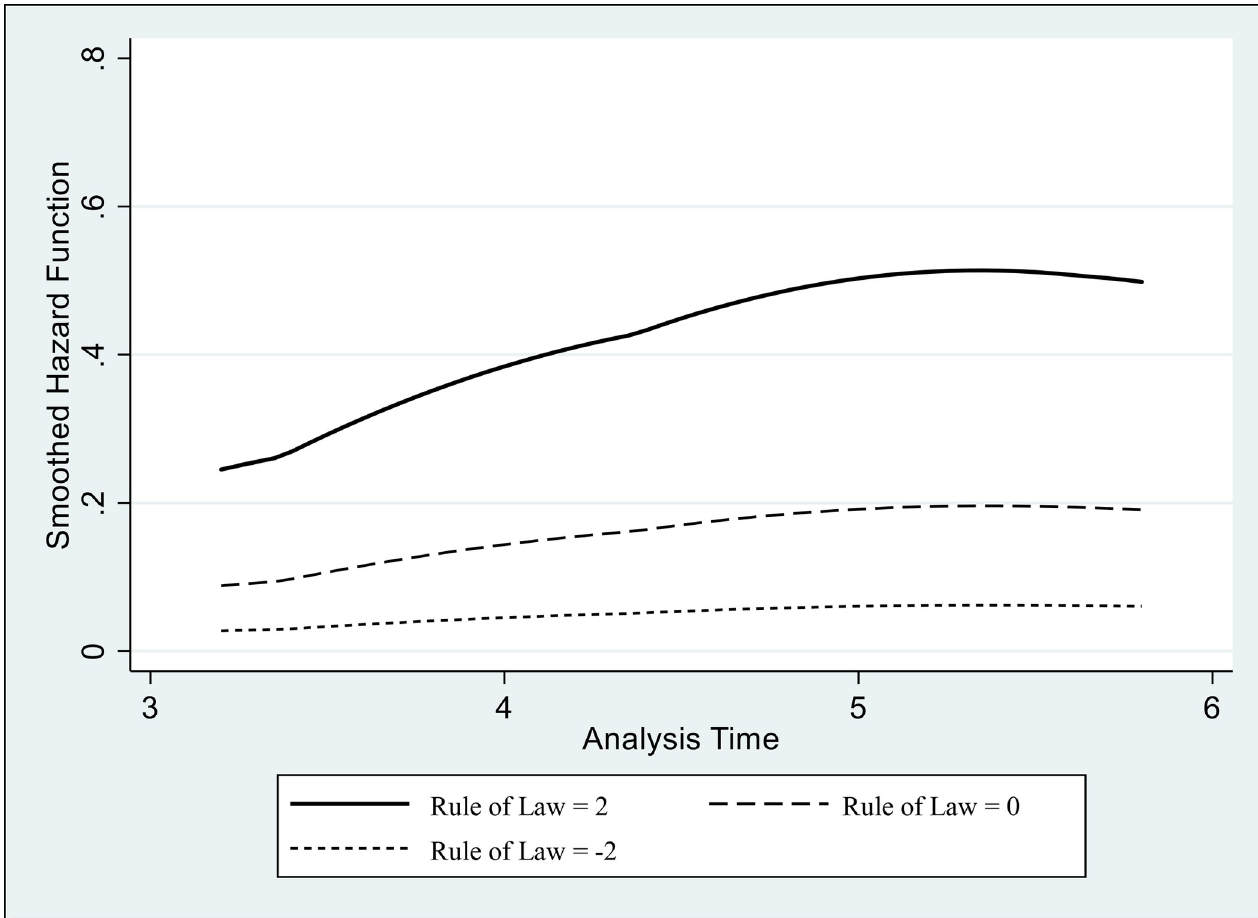
Fig 2. Rule of law and the hazard curves of the international diffusion of Uber. Higher Curve: Rule of Law = 2. Middle Curve: Rule of Law = 0. Lower Curve: Rule of Law = -2.